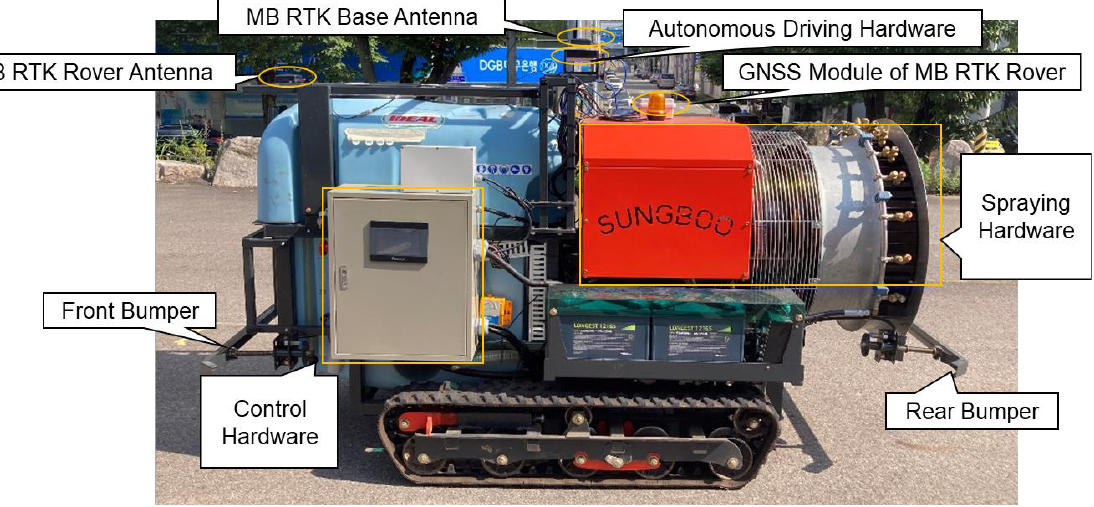
Figure 5. Prototype autonomous driving speed sprayer.